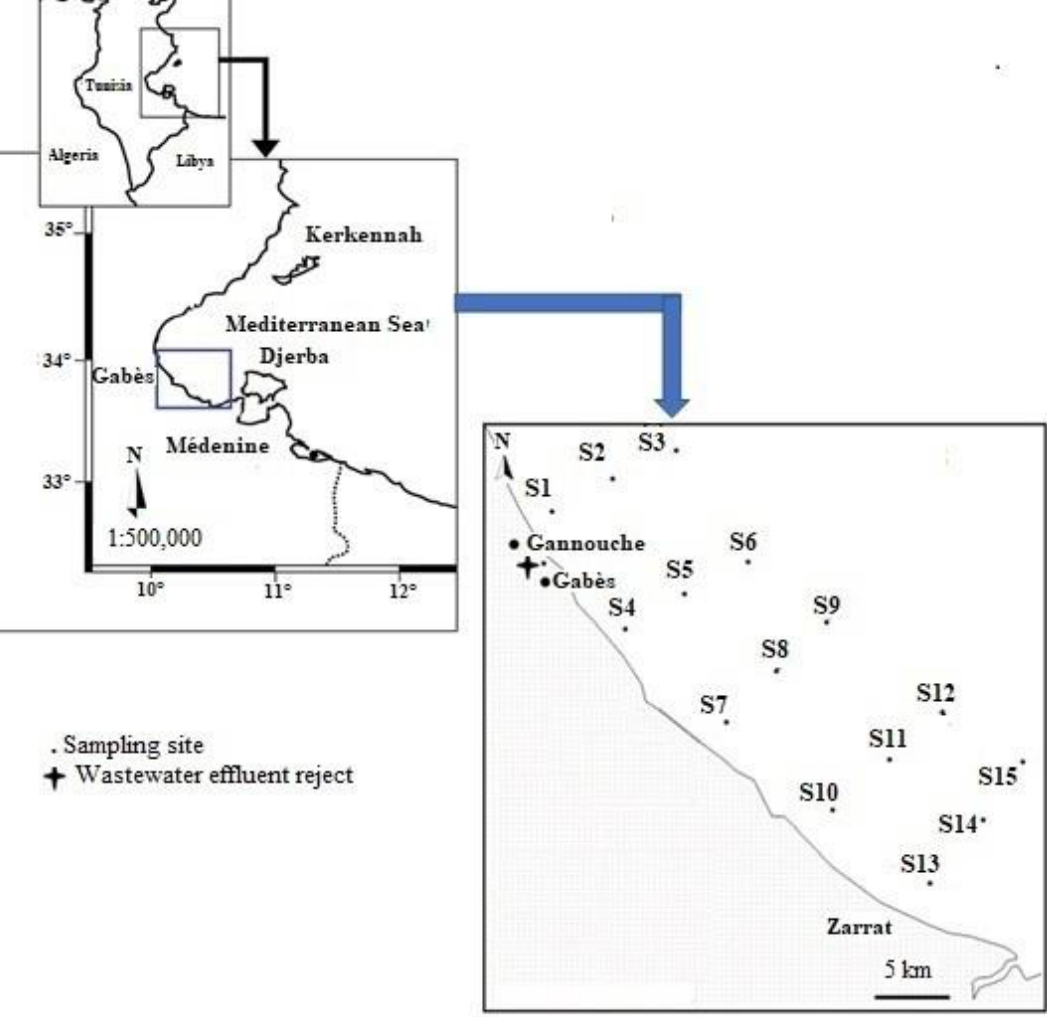
Figure 1. Location of sampling stations (S1–S15) along 5 transects perpendicular to the coastline of the Gulf of Gabès.